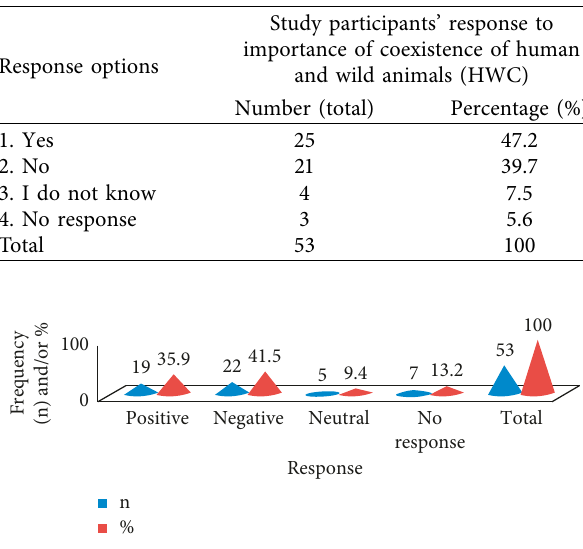
Figure 9: Attitude of study participants toward wild